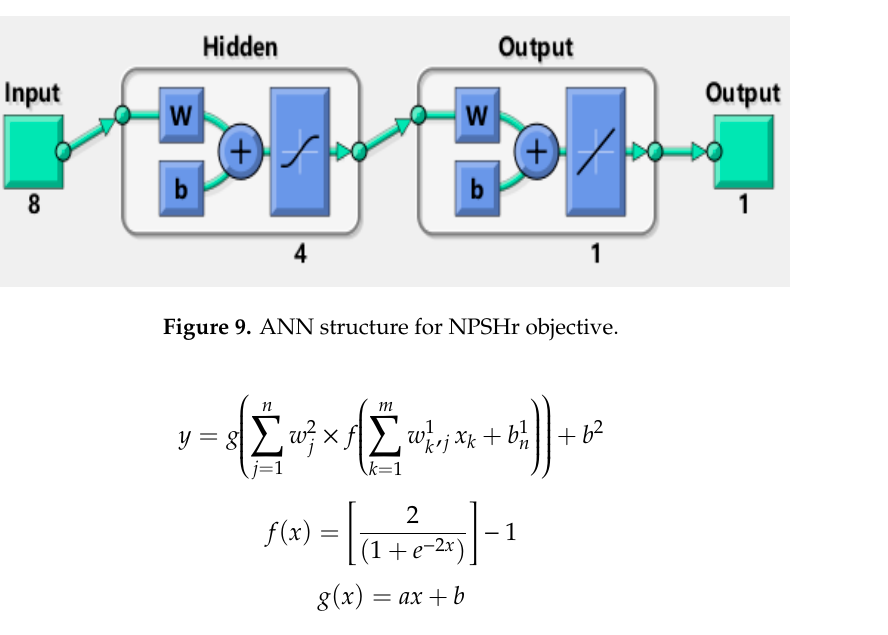
Figure 8. ANN structure for efficiency objective.